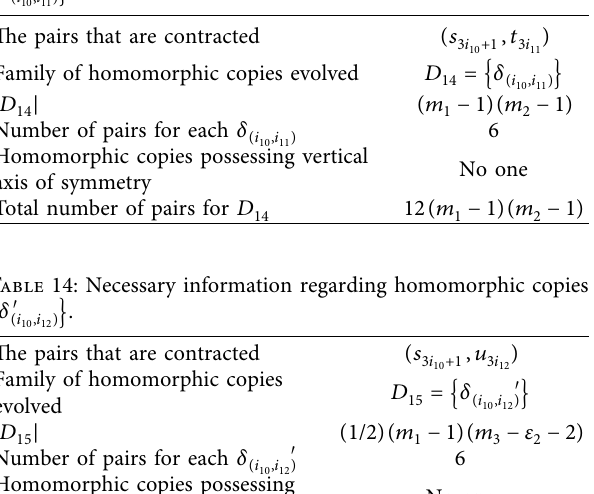
Number of pairs for each δ ( i vertical axis of